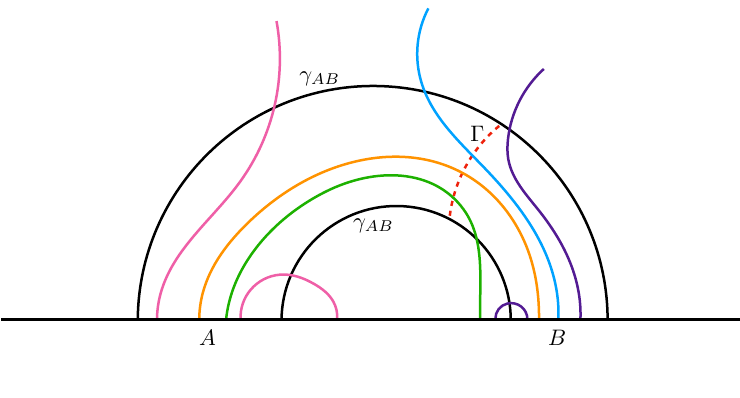
Figure 6 . The types of bit threads that can cross the RT surface of AB for the con(cid:12)guration that maximizes the (cid:13)ow out of AB as well as the (cid:13)ux through the entanglement wedge cross section (cid:0) (red dashed line). We have highlighted threads that have one end in A or B and cross both (cid:0) and the RT surface in green or blue,